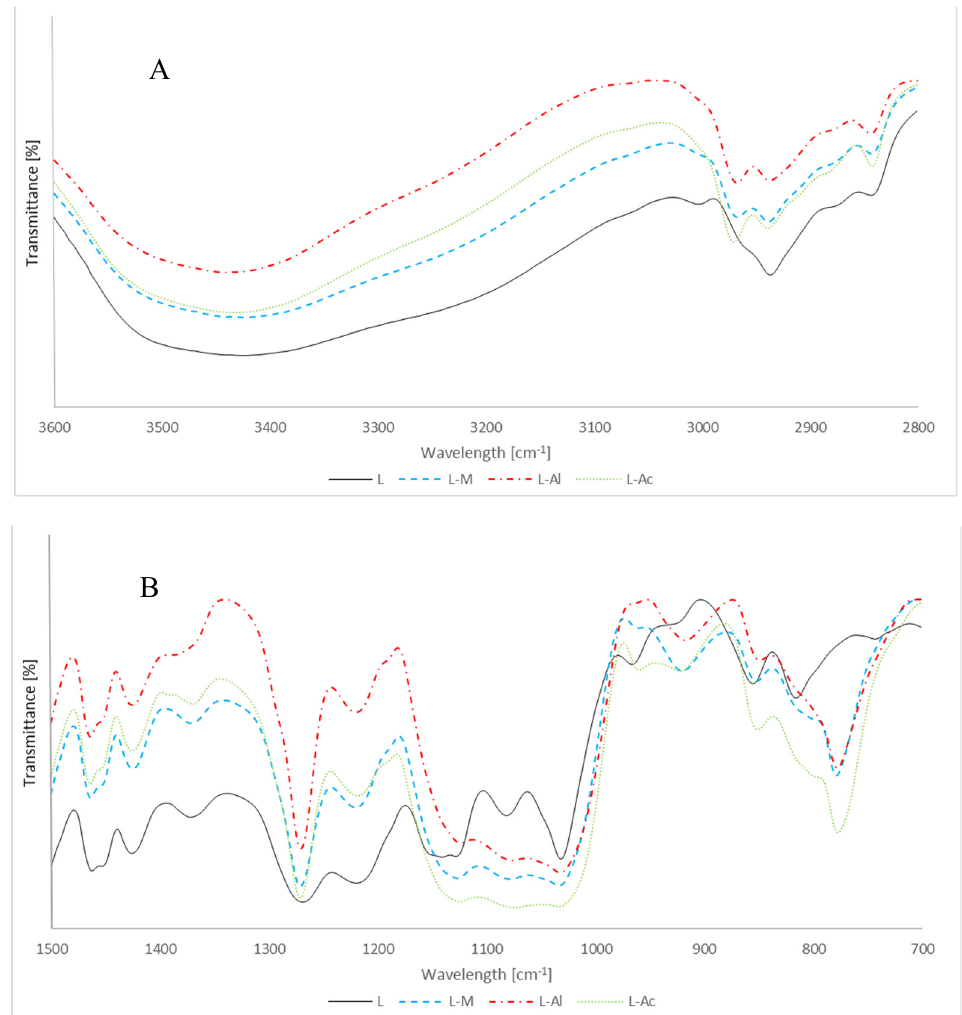
Figure 4. FT-IR spectra of silanizated lignin at the 3600 to 2800 cm − 1 range ( A ), and at the 1500 to 700 cm − 1 range ( B ).